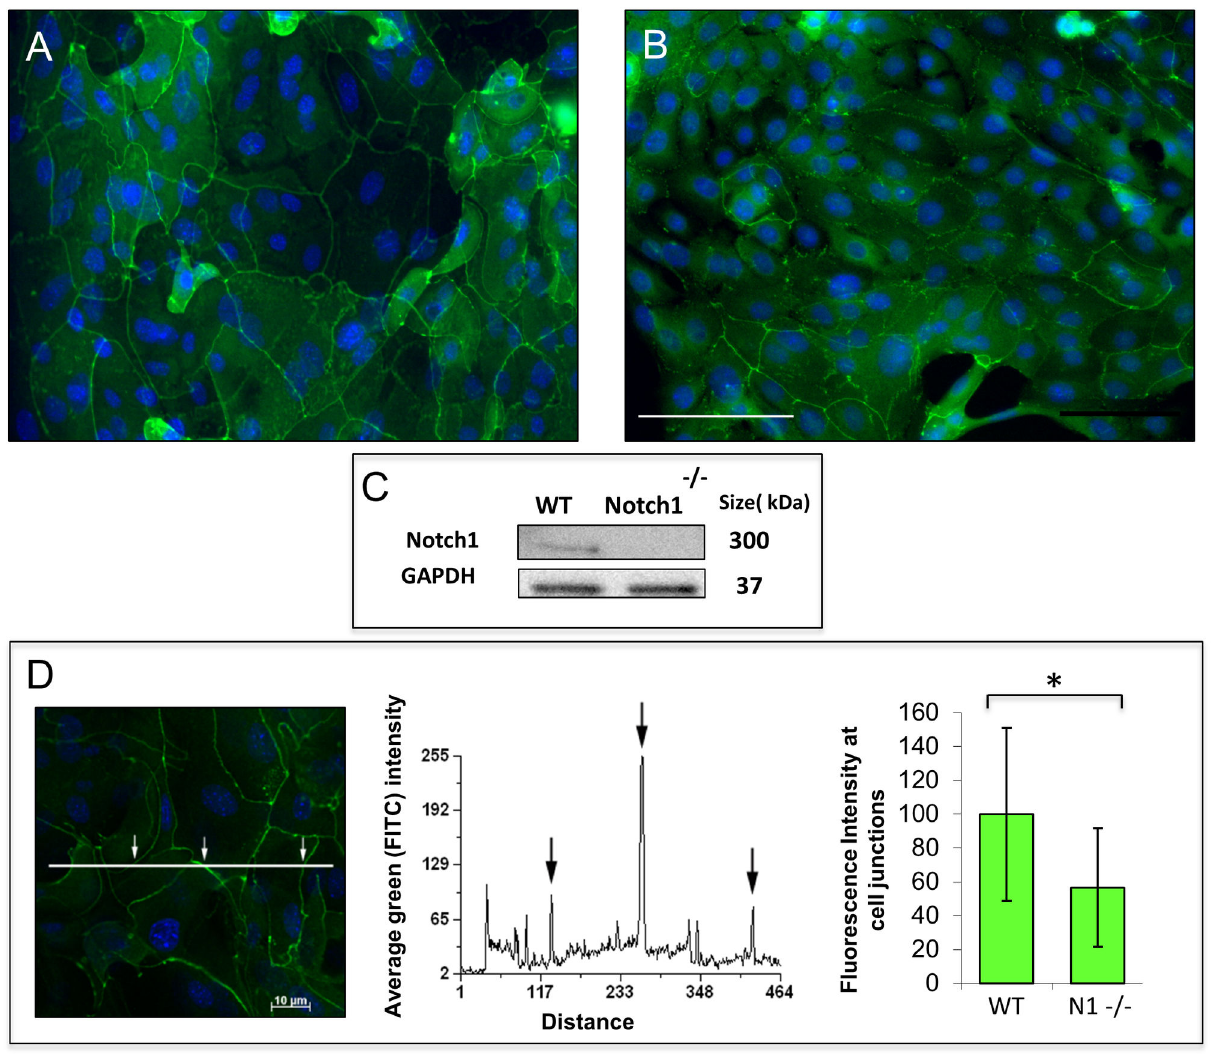
Figure 5. Notch1 -/- corneal epithelial cells have a delay in tight junction formation in vitro. After 12 hours in 1mM calcium, WT cells frequently showed continuous linear staining at the cell borders indicating more organized tight junctions (A). In contrast, Notch1 -/- cells exhibited predominantly non-continuous staining at the cell-cell junctions consistent with disorganized tight junction structures (B). Western blot confirmed deletion of Notch1 in knockout cells (C). The mean fluorescence intensity of ZO-1 staining at the cell membranes was measured and found to be higher for WT (arbitrarily set at 100%) compared to Notch1 -/- (56%) (D) (N = 119, P < 0.001); scale bar: 50